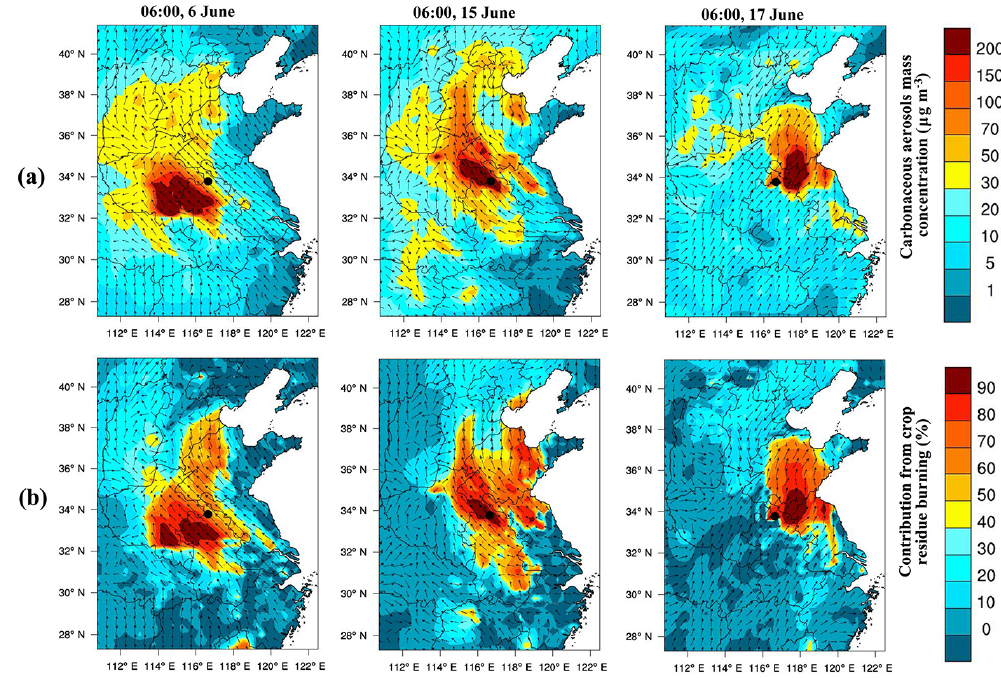
Figure 4. Spatial distributions of (a) carbonaceous aerosols mass concentration (µgm − 3 ) at the lowest model level ( ∼ 20m) and (b) its contribution from crop residue burning (%) in the three typical hours (06:00, GMT + 8.0) during the summer harvest (1–21 June) in June 2013. The location of the sampling site (Suixi) is indicated by the black dot. The arrows represent the surface ( ∼ 20m) wind